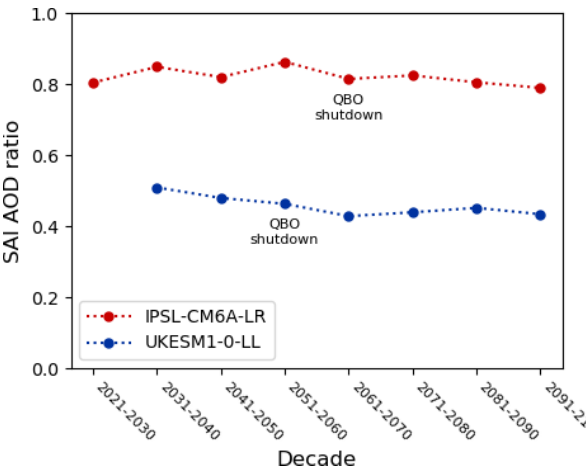
Figure 9. Evolution of the ratio of the mean stratospheric aerosol intervention (SAI) aerosol optical depth (AOD) in the subtropics to that in the SO 2 injection zone in ensemble member r1 of the two models whose G6sulfur experiments have both interactive SO 2 injection and a shutdown of the Quasi-Biennial Oscillation (QBO). The injection zone is the area between 10 ◦ N and 10 ◦ S as specified in Kravitz et al. (2015) and the subtropics are defined here as the region between 30 ◦ N and 30 ◦ S but excluding the injection zone. SAI was not required in UKESM1-0-LL until 2031 so the decade 2021–2030 is omitted for this